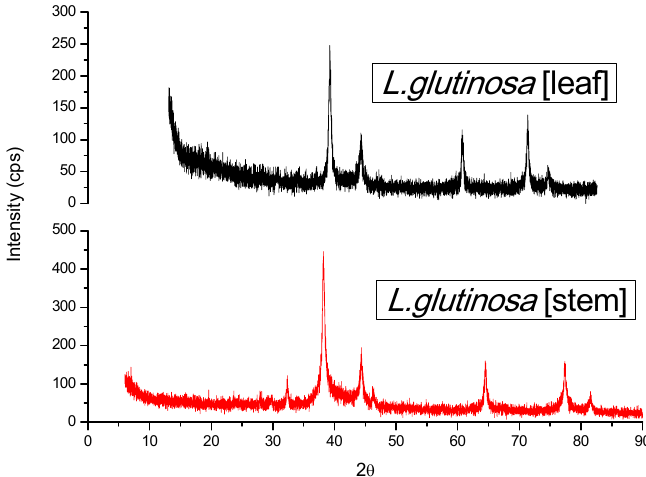
Fig. 2. X-ray diffraction analysis of L. glutinosa leaf and stem